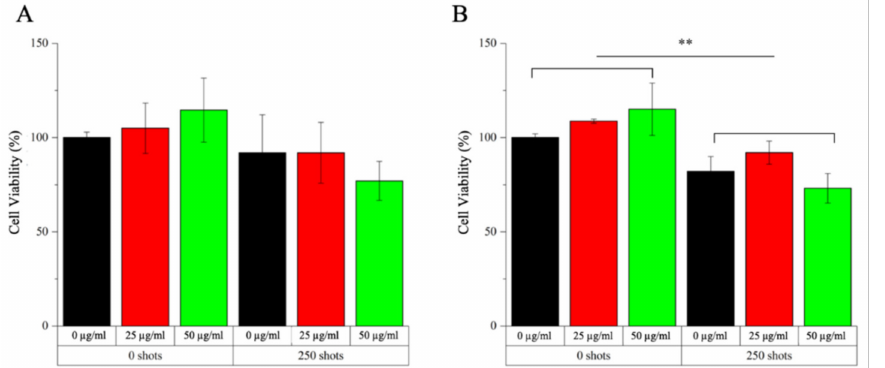
Figure 7. Study of EXTERNAL effects with a-TiO 2 -NH 2 /BSA NPs on Daudi cell line in combination with single ( A ) and multiple ( B ) SW treatments (3 times/day). Different samples are prepared per assay in absence (0 shots) or treated with shock waves (250 shots): control untreated cells (0 µ g/mL, black bars), cells with 25 µ g/mL a-TiO 2 -NH 2 /BSA in the cell culture medium (25 µ g/mL, red bars) or cells with 50 µ g/mL a-TiO 2 -NH 2 /BSA (50 µ g/mL, green bars) and immediately treated with SW. Cell viability is then recorded 24 h after the SW treatment with the WST-1 proliferation reagent. Data are reported as the cell viability with respect to the control referred as the 100%. Bars represent mean percentages of cell viability with respect to the control cells ± SEMs, n ≥ 2. 2-way ANOVA was performed to determine statistical significance (** p <